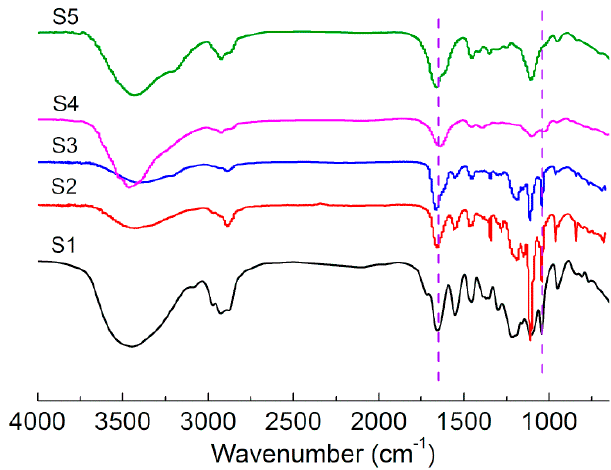
Figure 1. FT-IR spectra of the five prepared polymers.